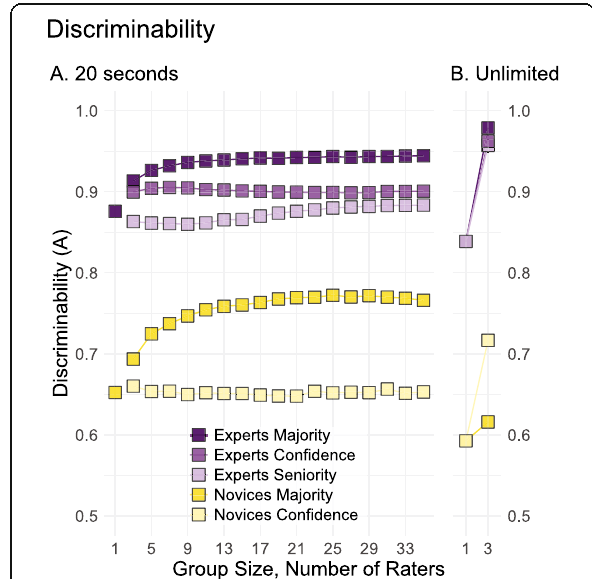
Fig. 3 Mean discriminability scores ( A ) for experts (purple) and novices (yellow) after 20 s of analysis ( a ) or without a time limit ( b ). The different shades of each color represent the three aggregation rules: (1) follow-the-majority; (2) follow-the-most-confident; and (3)